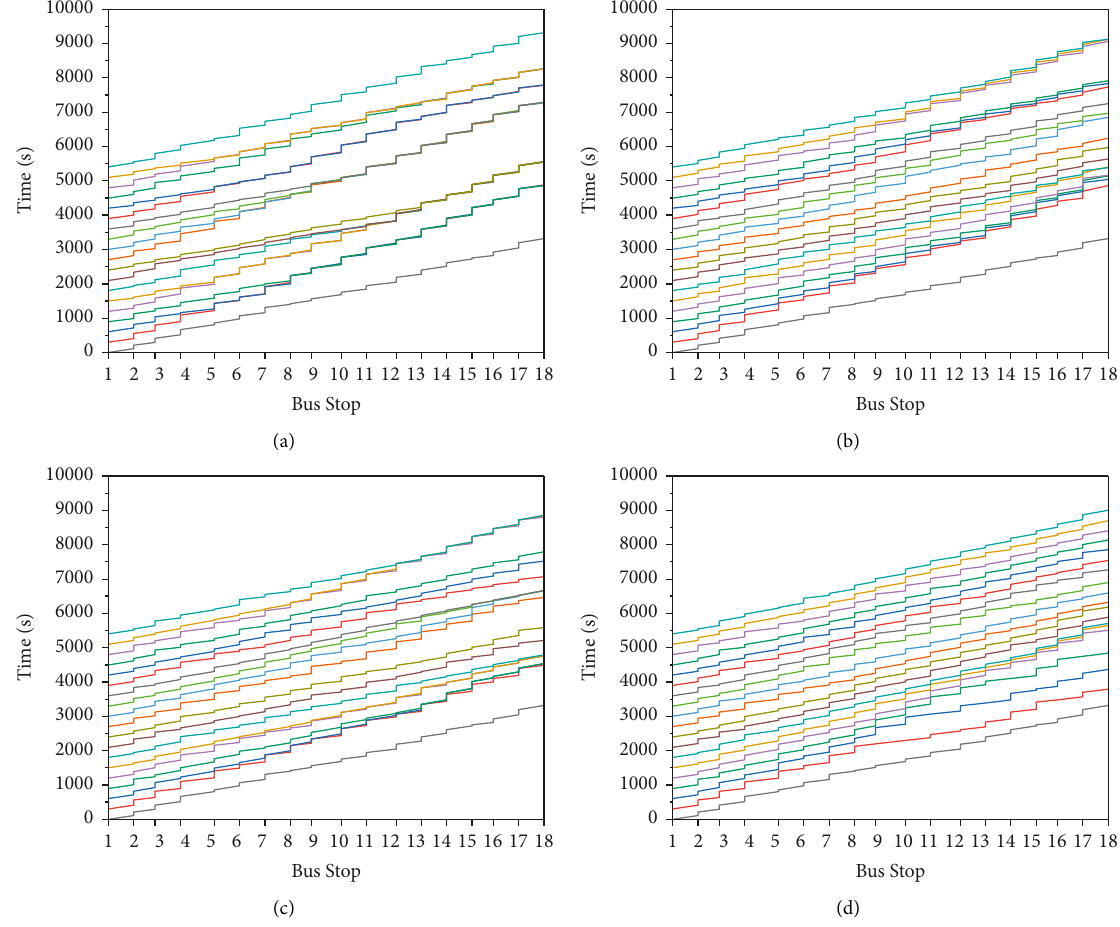
Figure 10: Bus trajectories. (a) NC. (b) HC. (c) SC. (d)